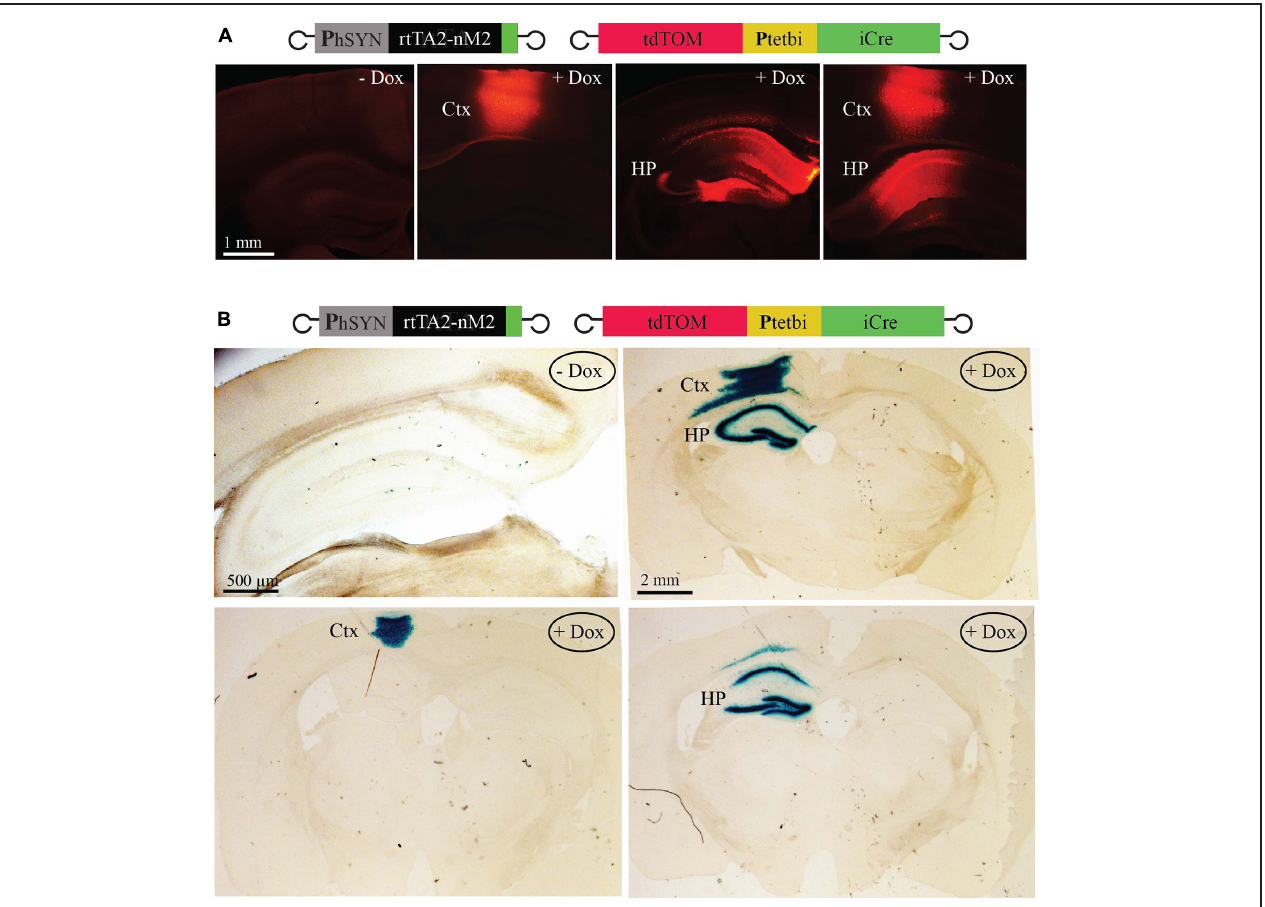
FIGURE 4 | Inducible, Cre/loxP mediated gene recombination. (A) With precisely targeted virus injection, induced tdTOM expression in cortex alone, hippocampus alone and both cortex and hippocampus. (B) Cre/loxP mediated recombination to activate the lacZ gene in